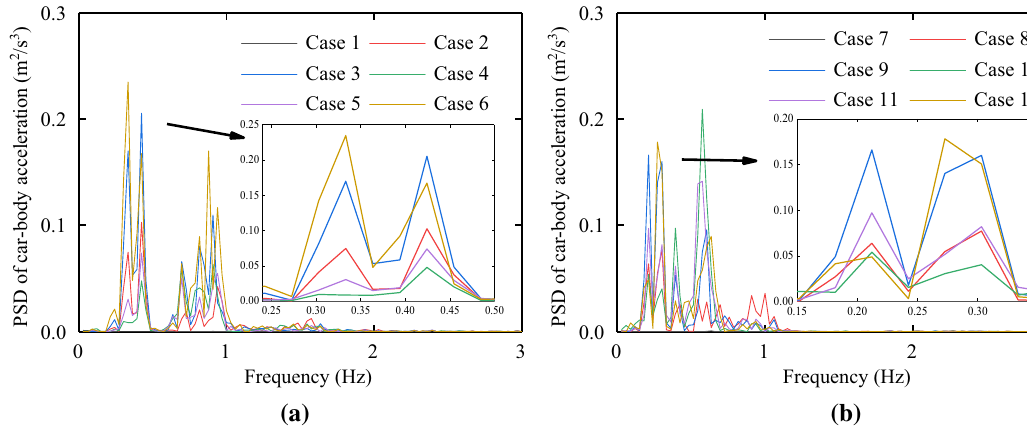
Fig. 16 PSD of the lateral car-body acceleration: a cases 1–6; b cases 7–12